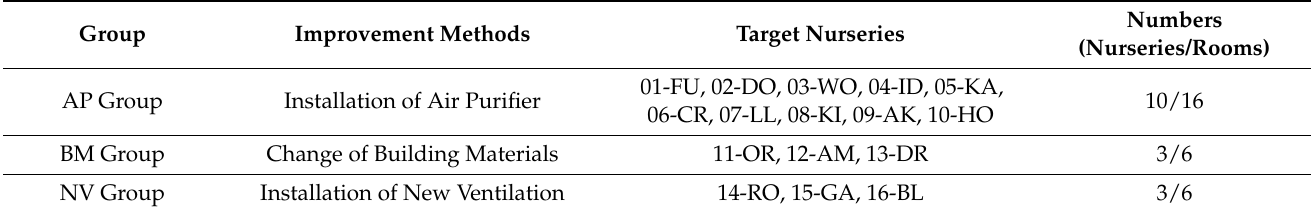
Table 3. Indoor Air Pollutants Measuring Devices and